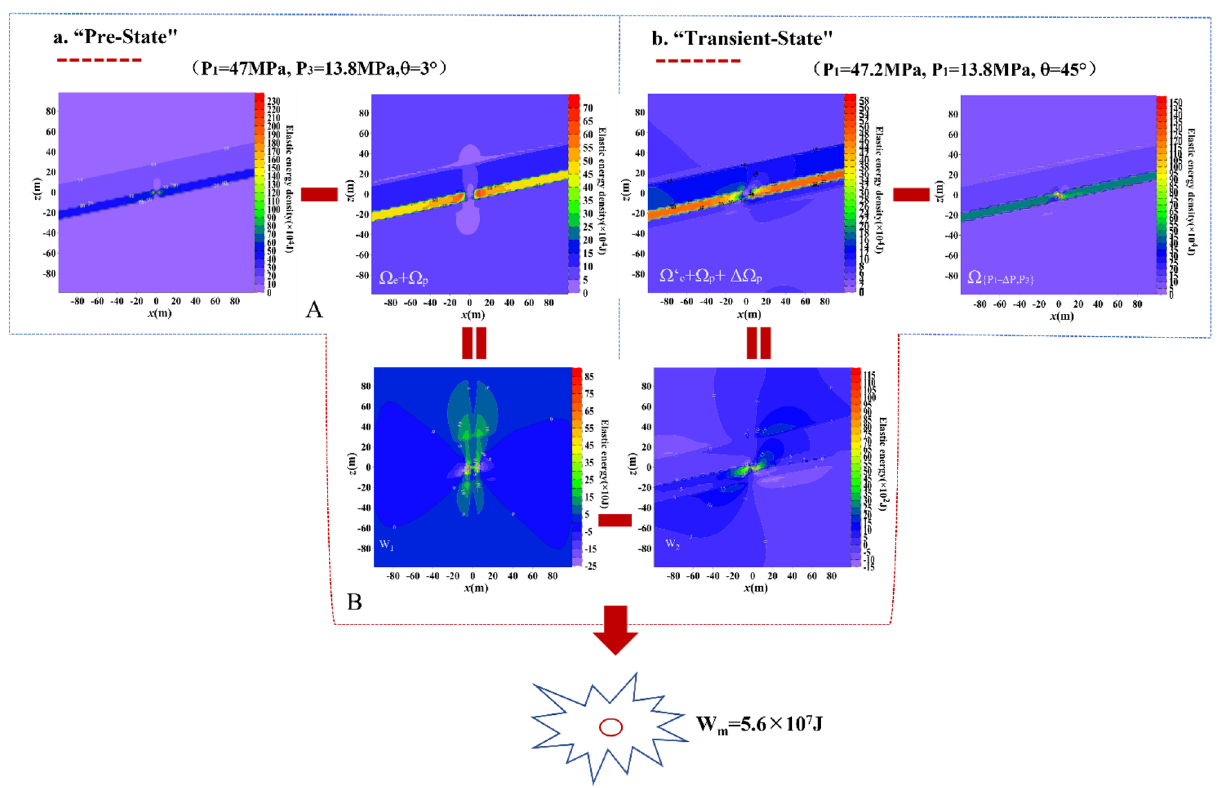
Fig. 10 Distribution characteristics and transformation relationship of elastic energy density of surrounding rock accumulation in the “pre-state” and “transient state” of